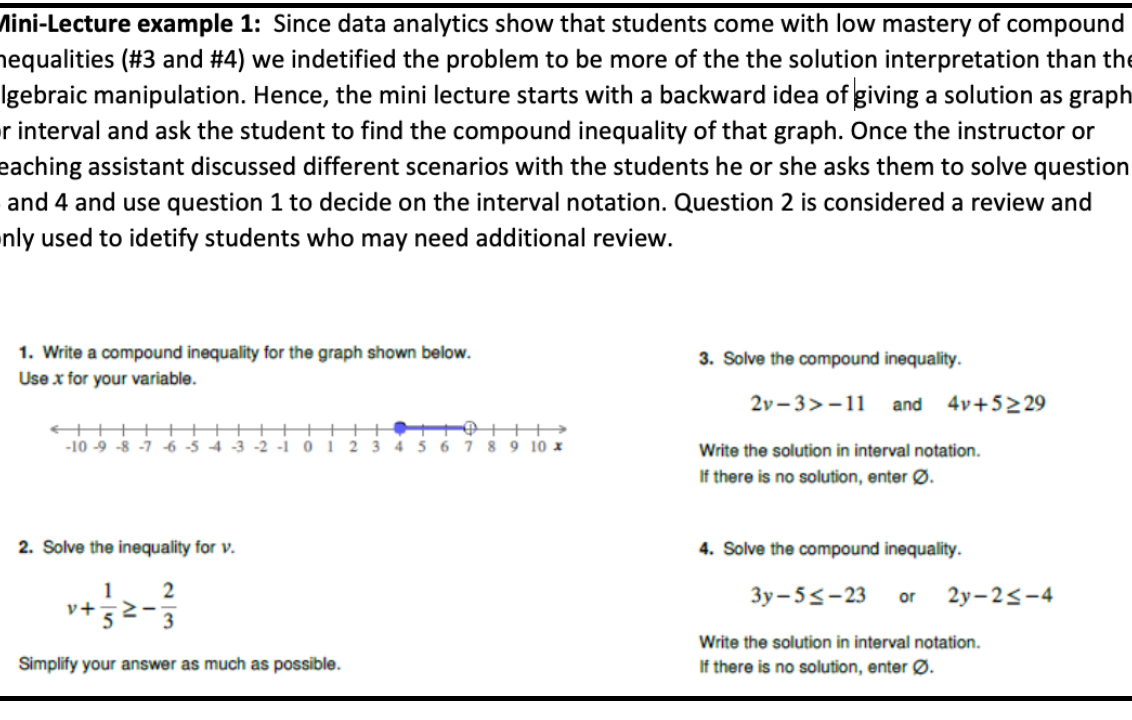
Figure 10. Sample in-class mini-lesson for students with low mastery of compound inequalities in